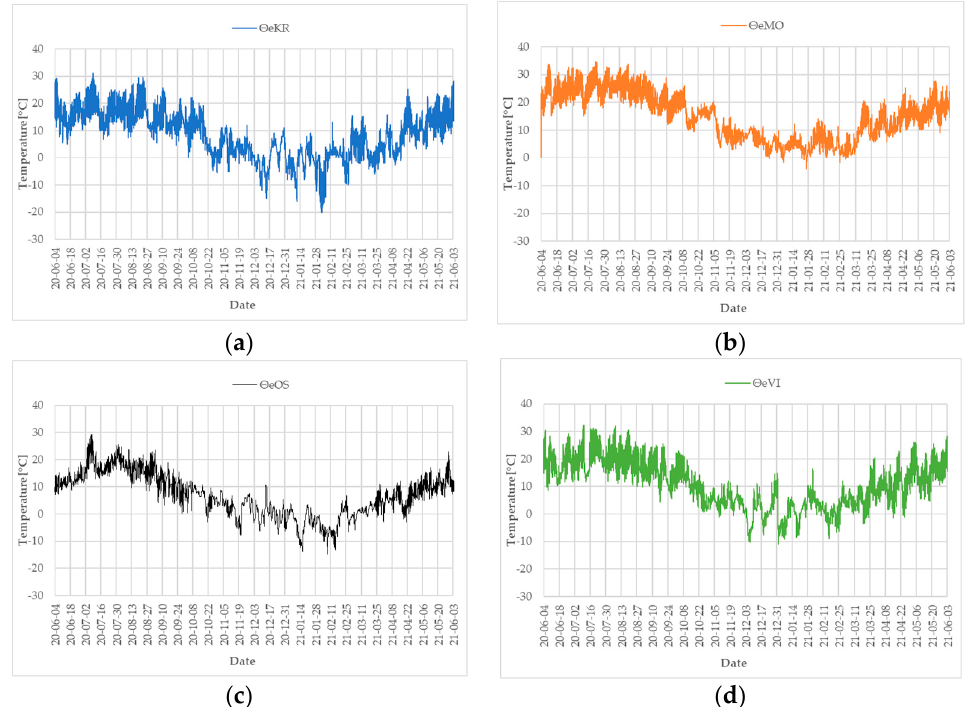
Figure 10. The course of outdoor air temperature in Krakow ( Θ e KR) ( a ), Modena ( Θ e MO) ( b ), Oslo ( Θ e OS) ( c ) and Vienna ( Θ e VI) ( d ).